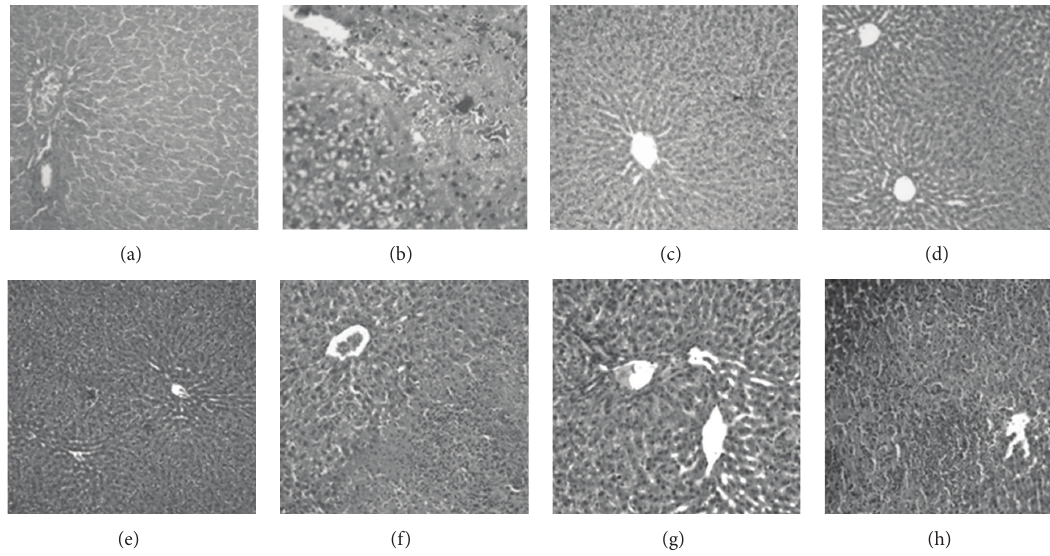
Figure 3: Effects of N-acetylcysteine (NAC) and/or iron (Fe) short-term administration on rat liver histology in animals subjected to ischemia-reperfusion (IR). Animals were treated as shown in Figure 1. Representative liver sections from control-sham (a), control-IR (b), Fe-sham (c), and Fe-IR (d) animals, and NAC-treated rats subjected to sham operation (e), IR (f), Fe-pretreatment and sham-operation (g), Fe pretreatment and IR (h) (hematoxylin-eosin-stained liver sections from a total of 3 to 4 animals per experimental group; original magnification ×